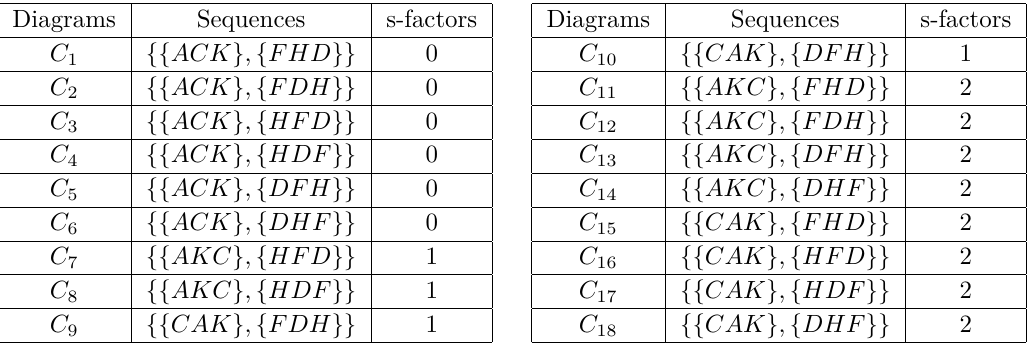
Table 17. Normal ordered diagrams of Cweb W (4)